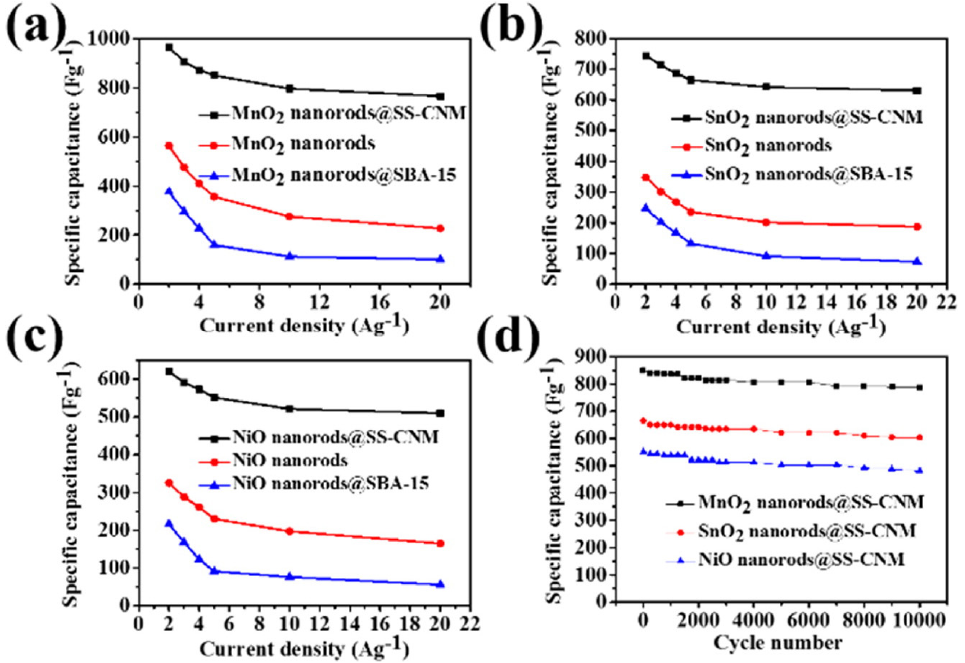
Figure 13. Curves of specific capacitance versus varied current density of MnO